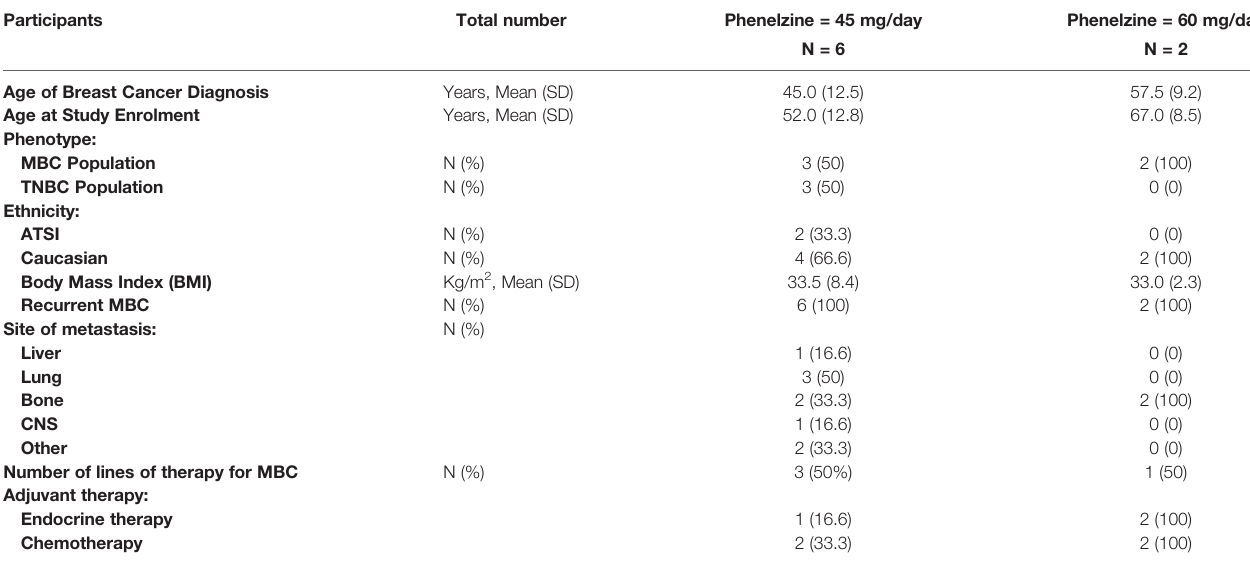
TABLE 1 | Demographic